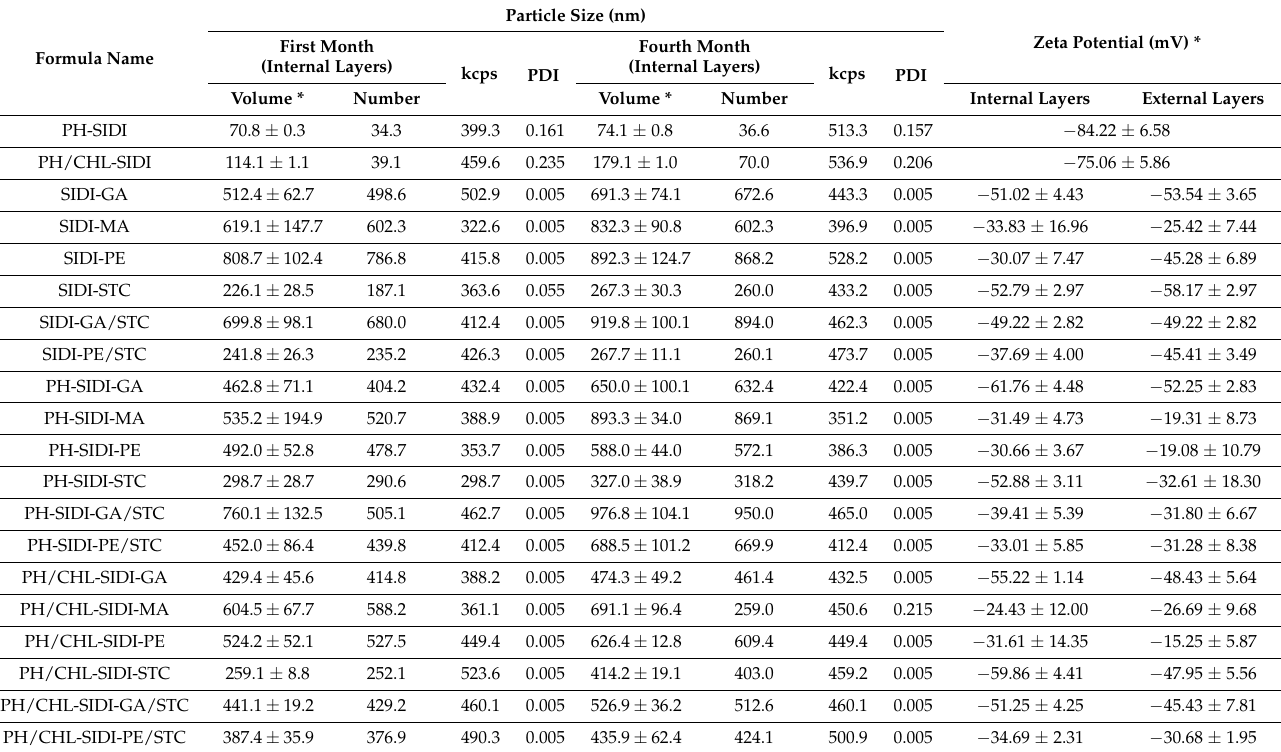
Table 4. Particle size (internal layers, nm) and zeta potential (mV) of internal and external